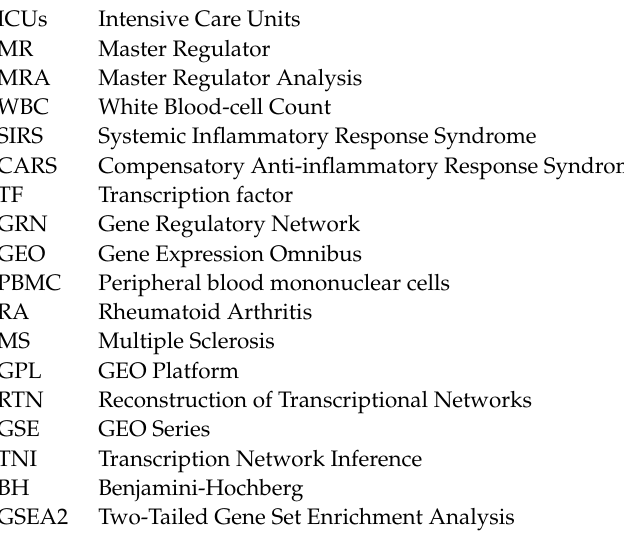
intersection, Figure S3: Cumulative variance of co-variables; Table S1: Complete MR list from GSE13904 network, Table S2: Complete MR list from GSE4607 network, Table S3: Intersected MR list among GSE13904 and GSE4607 network, showing GSE13904 data, Table S4: Intersected MR list among GSE13904 and GSE13904 network, showing GSE4607 data, Table S5: Intersected MR list among clusters inside Pediatric Sepsis 1 network (GSE13904), Table S6: Intersected MR list among clusters inside Pediatric Sepsis 2 network (GSE4607), Table S7: Final MR list showing Pediatric Sepsis 1 (GSE13904) data, Table S8: Final MR list showing Pediatric Sepsis 2 (GSE4607) data, Table S9: Reference list for the 15 final